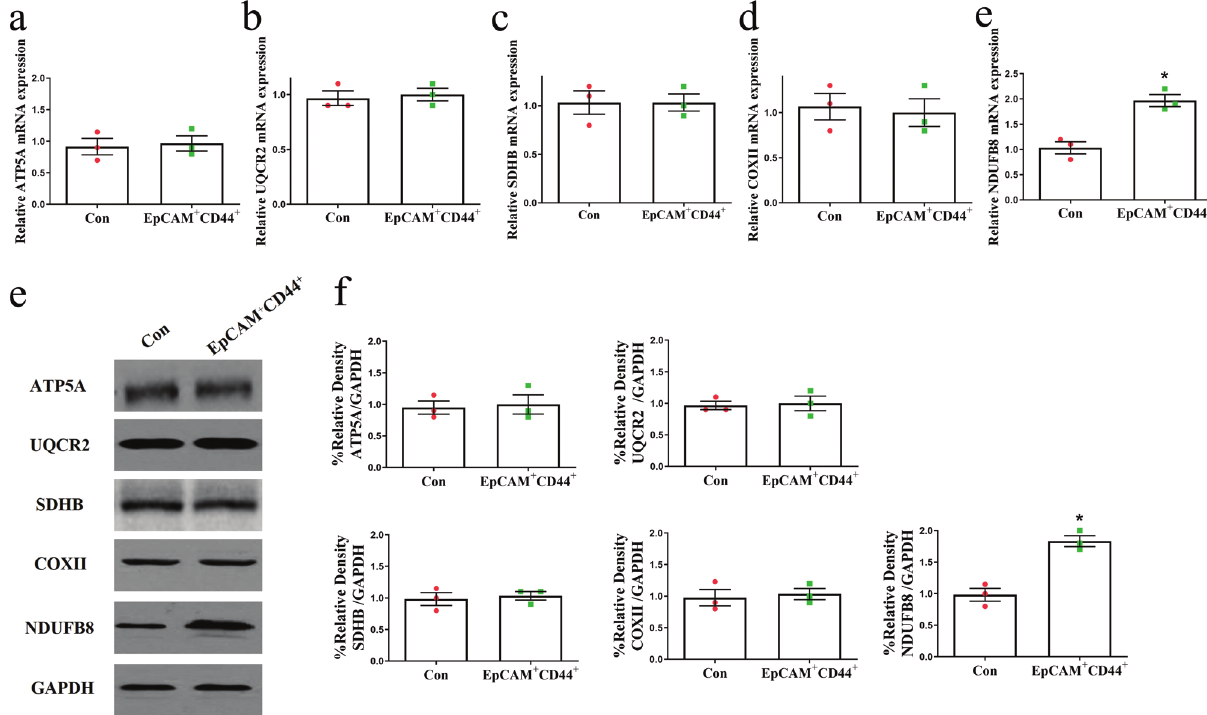
Fig. 2. mRNA and protein expression of five mitochondrial proteins of EpCAM + CD44 + cells and control cells. mRNA level of ATP5A (a), UQCR2 (b), SDHB (c), COXII (d) and NDUFB8 (e). (f) Representative Western blot analysis showing the abundance of five mitochondrial proteins (ATP5A, UQCR2, SDHB, COXII and NDUFB8) belonging to respiratory chain complexes (V, III, II, IV, and I, respectively). Results are expressed as mean ± SD ( n = 3). * P < 0.05 versus